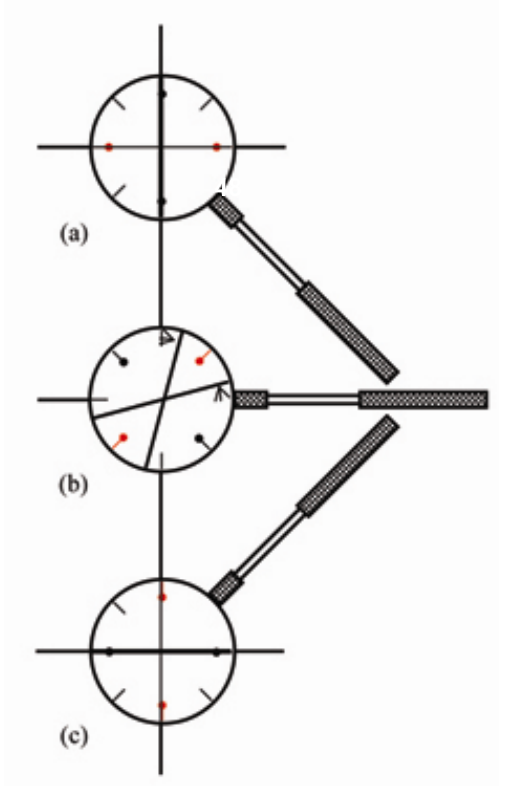
Figure 7 The scissors effect observed when a distant cross is viewed through the Jackson cross-cylinder. The lens is rotated anticlockwise from the primary position in (a) to 45° in (b) and to 90° in (c). The upright of the cross appears initially to rotate in the opposite sense (clockwise) until it reaches an extreme orientation in (b) after which it rotates in the same sense (anticlockwise) back to the vertical in (c). The cross-piece exhibits the opposite behaviour. The thickness of the upright is magnified in (a) and minified in (c), the opposite being the case for the